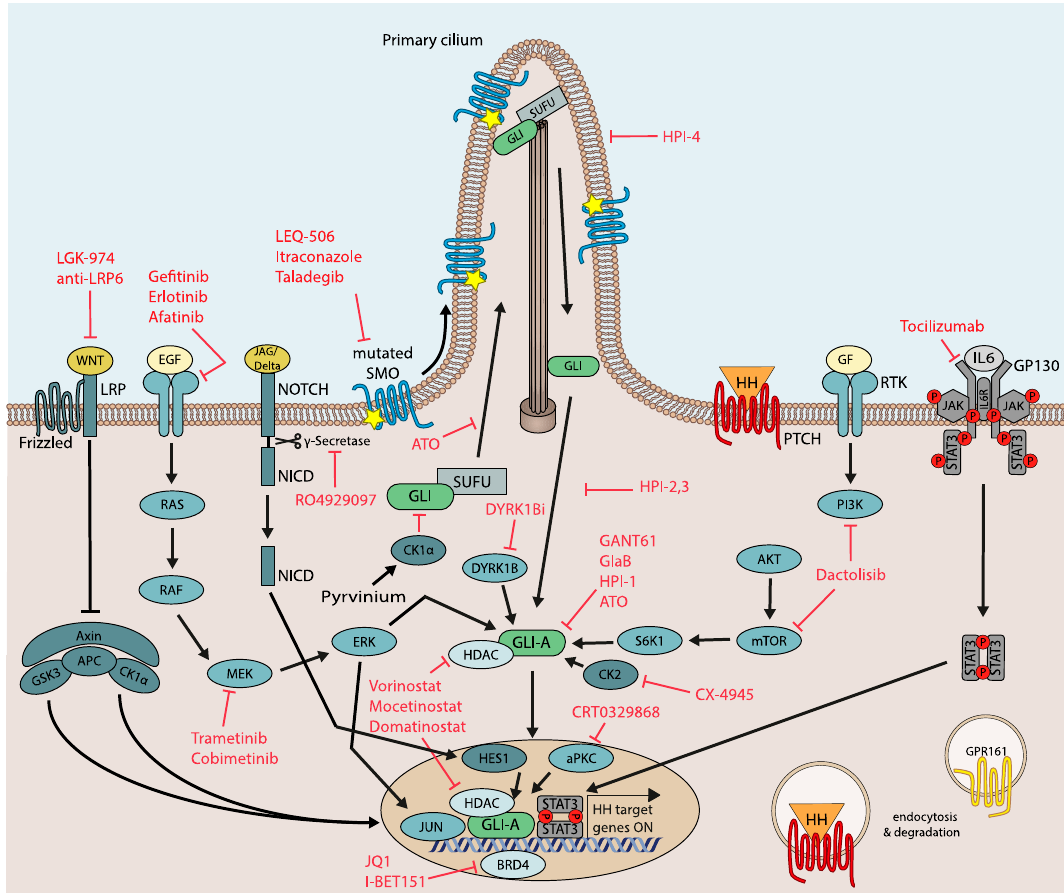
Figure 3. Therapeutic targeting of oncogenic HH/GLI signaling in cancer cells resistant to SMOi. Summary of targeting options to block pathways and signaling mechanisms accounting for SMO- independent GLI activation and SMOi resistance development. GF: Growth